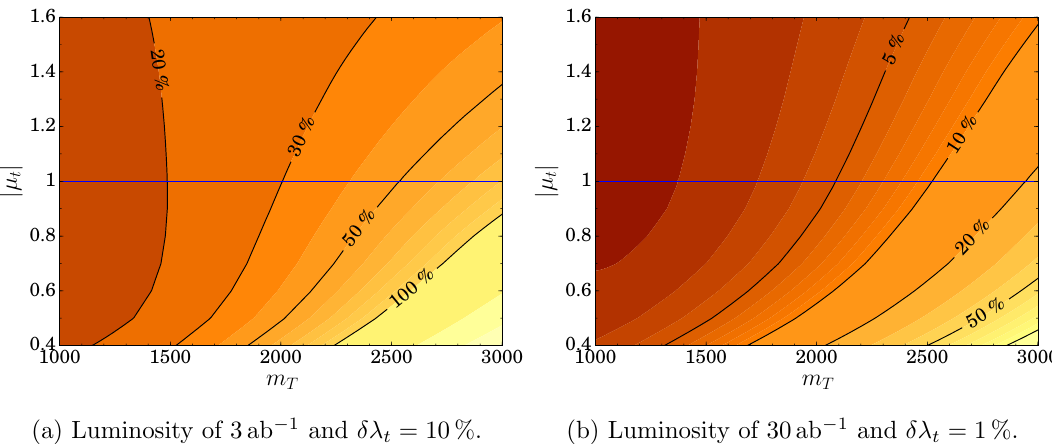
Figure 7. Precision of measuring the absolute value of the naturalness parameter with 3 and 30 ab (cid:0) 1 of data. We assume the uncertainty of measuring (cid:21) t to be 10 % and 1 %,